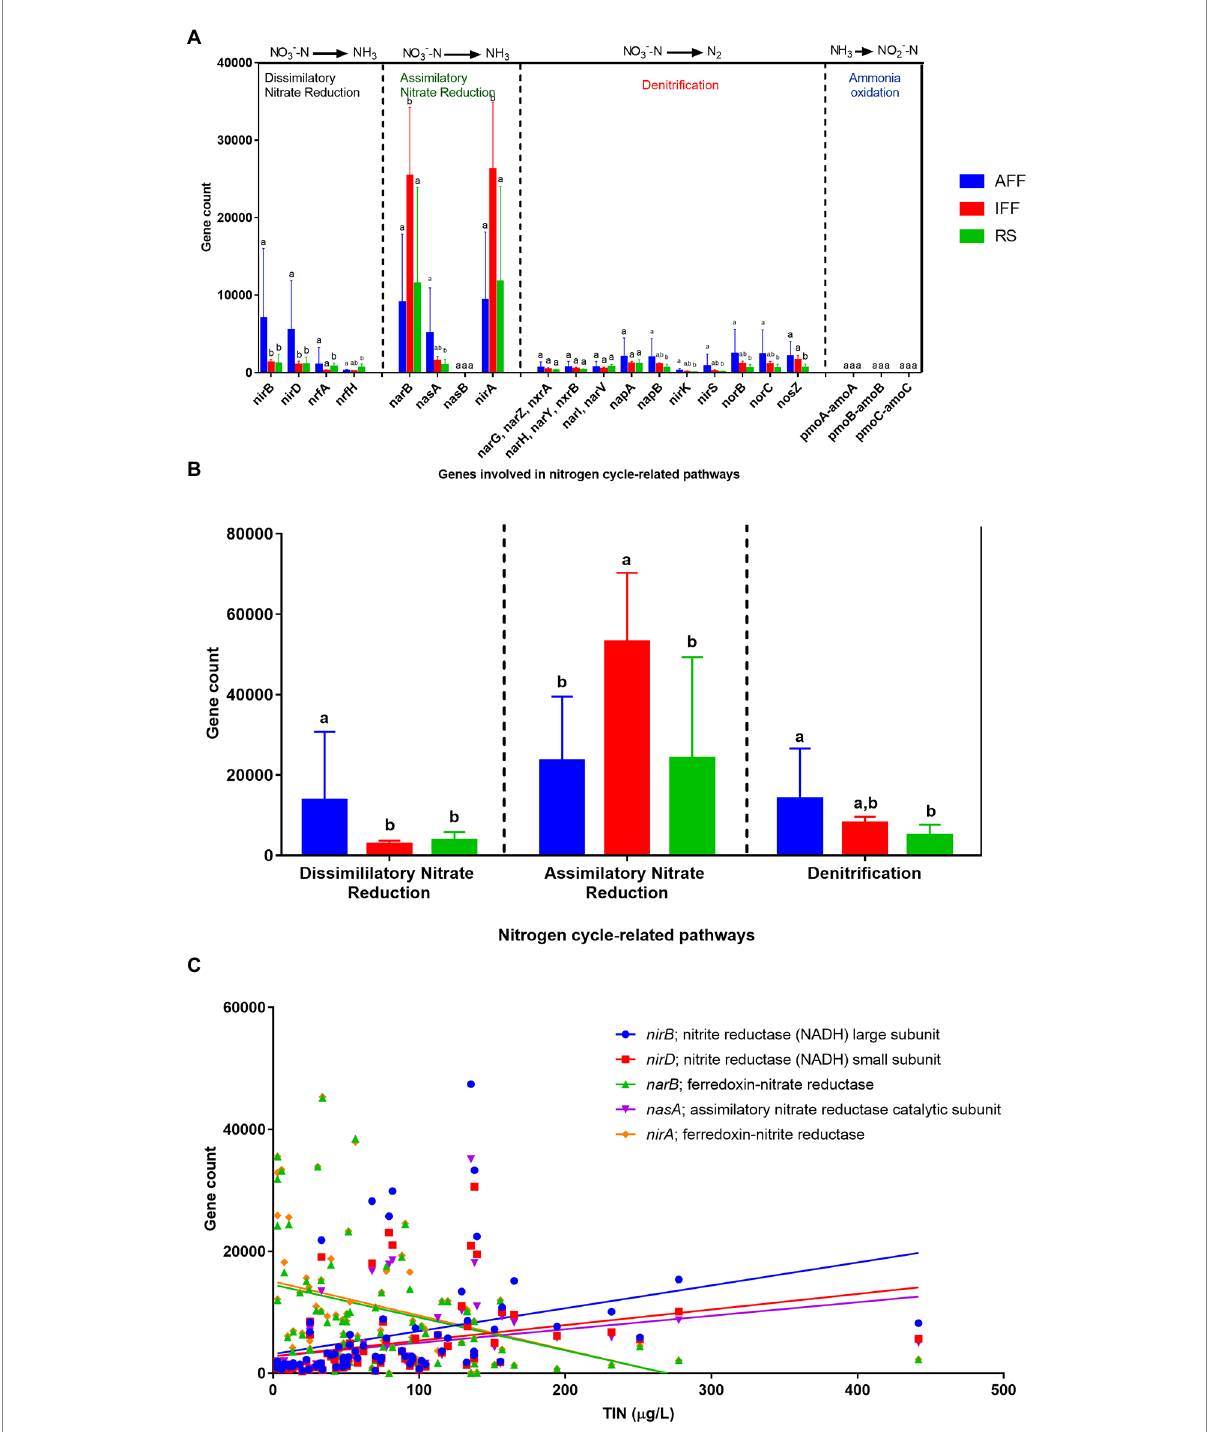
FIGURE 10 Summary of the mean abundance of (A) nitrogen cycle-related pathways and (B) the contributing genes, as well as (C) Spearman’s correlation between major nitrogen cycle-related genes and total inorganic nitrogen concentration in Hong Kong coastal bacterial communities. Different letters indicate statistically significant differences (Kruskal-Wallis test, p < 0.05). AFF, active fish farm; IFF, inactive fish farm; RS, reference